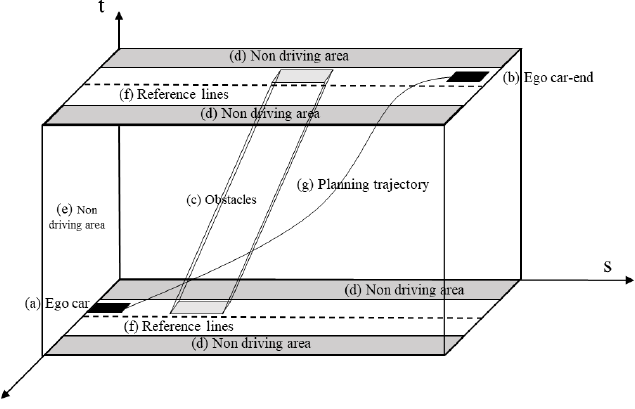
Figure 2. A time series bird ’ s-eye view matrix diagram .